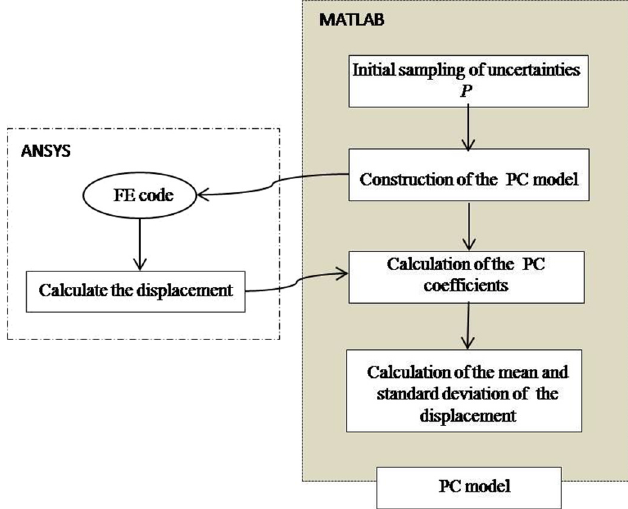
Fig. 4. Flowchart of the PC